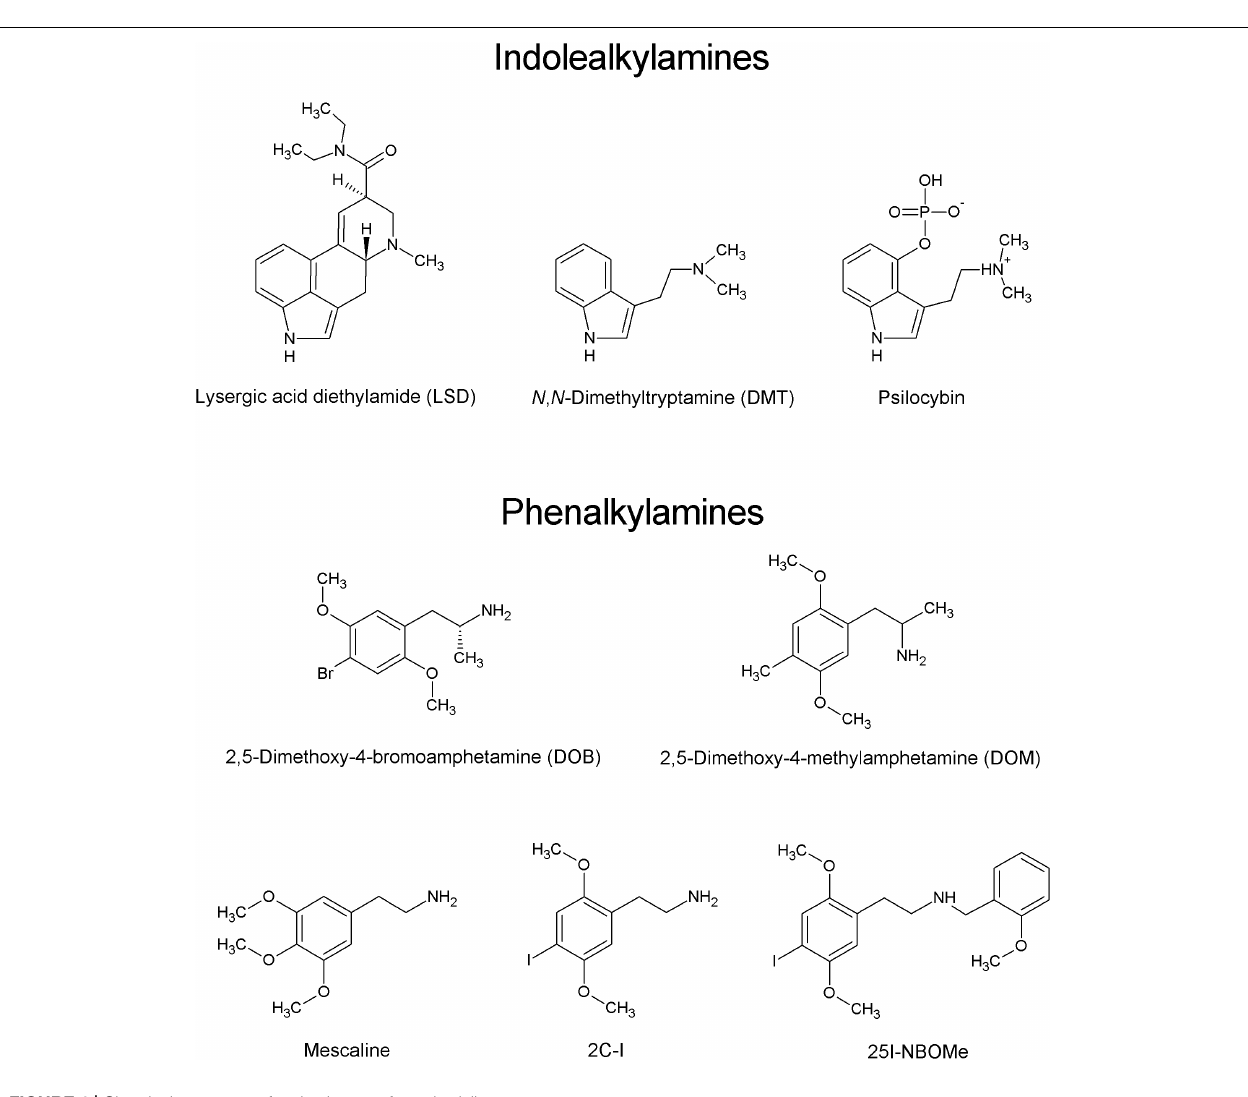
FIGURE 1 | Chemical structures of main classes of psychedelics.